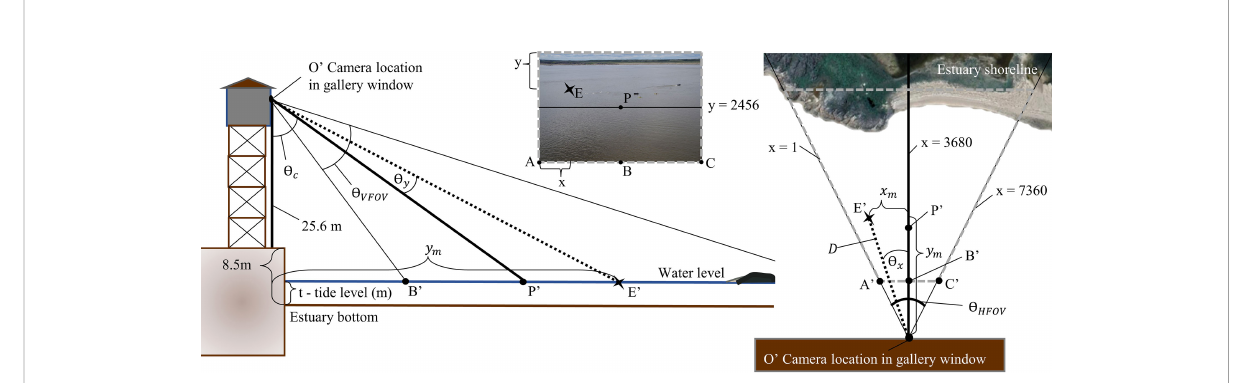
FIGURE 4 Side view (left) and bird ’ s eye view (right) of camera set up in the Port of Churchill gallery. Location of multiple points on an oblique photo (A – C, P) are represented in this diagram (A ’ , B ’ , C ’ , P ’ ) to translate between the image and real-world calculations. The star (points E and E ’ ) shows how a location in the real-world would be found on a photo with pixel coordinates at